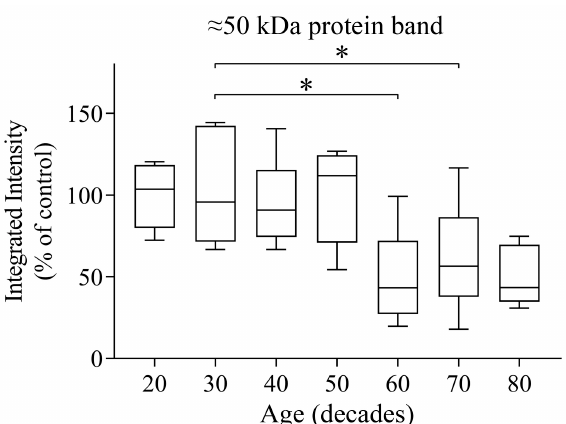
Figure 6. Resolution of proteins from the PFC of humans of progressive age and Western blotting. ( A ) PFC cytosolic proteins were resolved by one dimensional polyacrylamide gel electrophoresis and stained with colloidal Coomassie. A reduction of the protein band at ≈ 50 kDa was apparent for most subjects over 60 years of age (marked with arrowheads). Western blotting confirmed that the reduced protein staining reflected a lowering of α - and β -tubulin expression. ( B ) Quantification of the changes of protein expression of α - and β -tubulins, and GAPDH across the age range of 21–86 years, with data presented as box plots. GAPDH blots were normalized to total protein staining. For marked significance: * = p < 0.05, ** = p < 0.01. ( C ) Densitometric quantitation of the ≈ 50 kDa protein band across the age range of 21–86 years, with data presented as box plots. For marked significance: * = p < 0.05.